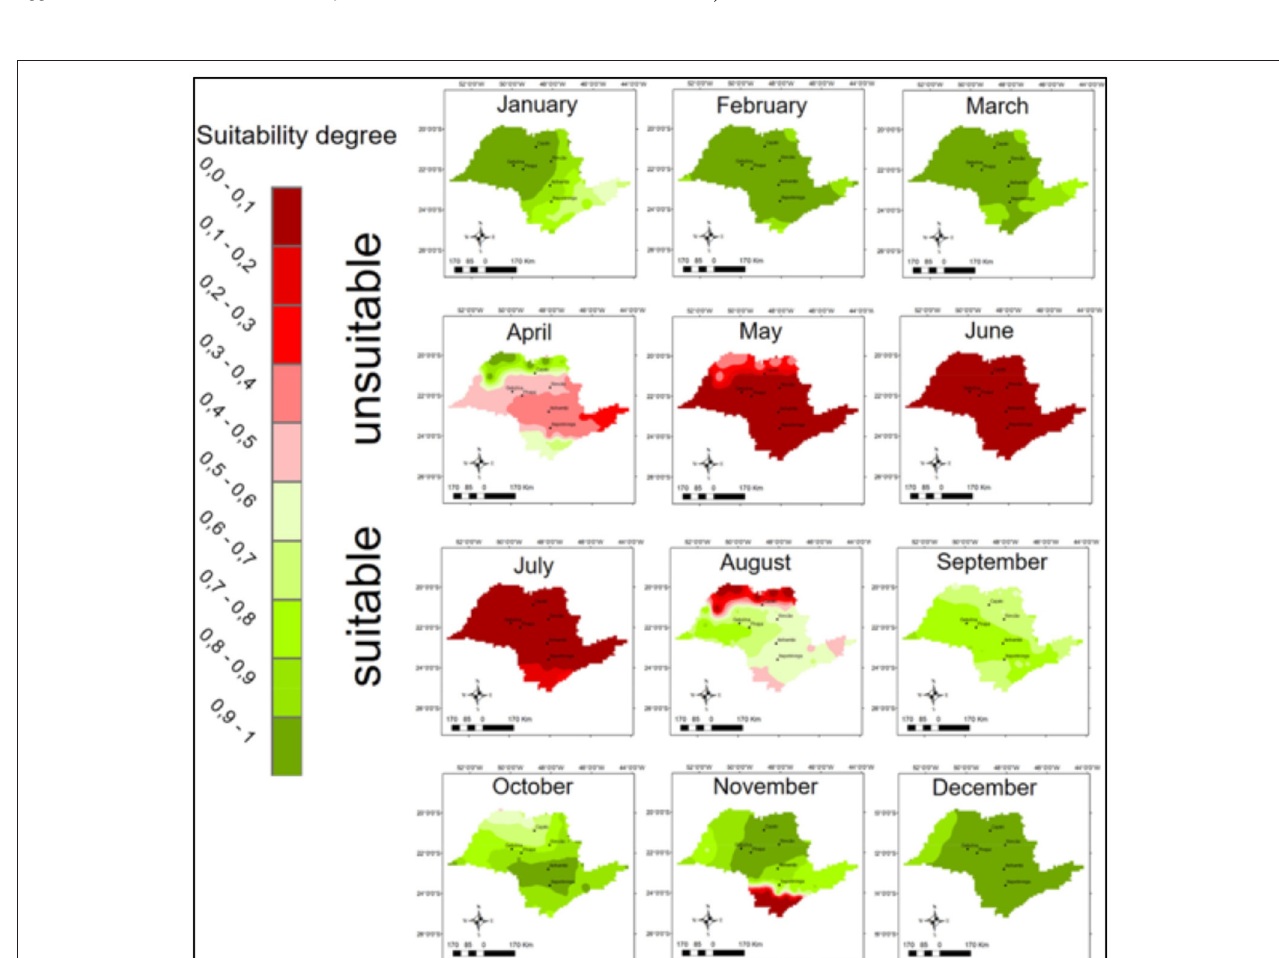
FIGURE 5 | Map of the state of São Paulo, Brazil (main citrus-producing region in the country), showing the fuzzy-based index values (suitability indexes) for different areas. The indexes indicate the more suitable areas for biological control (Garcia et al., 2019).